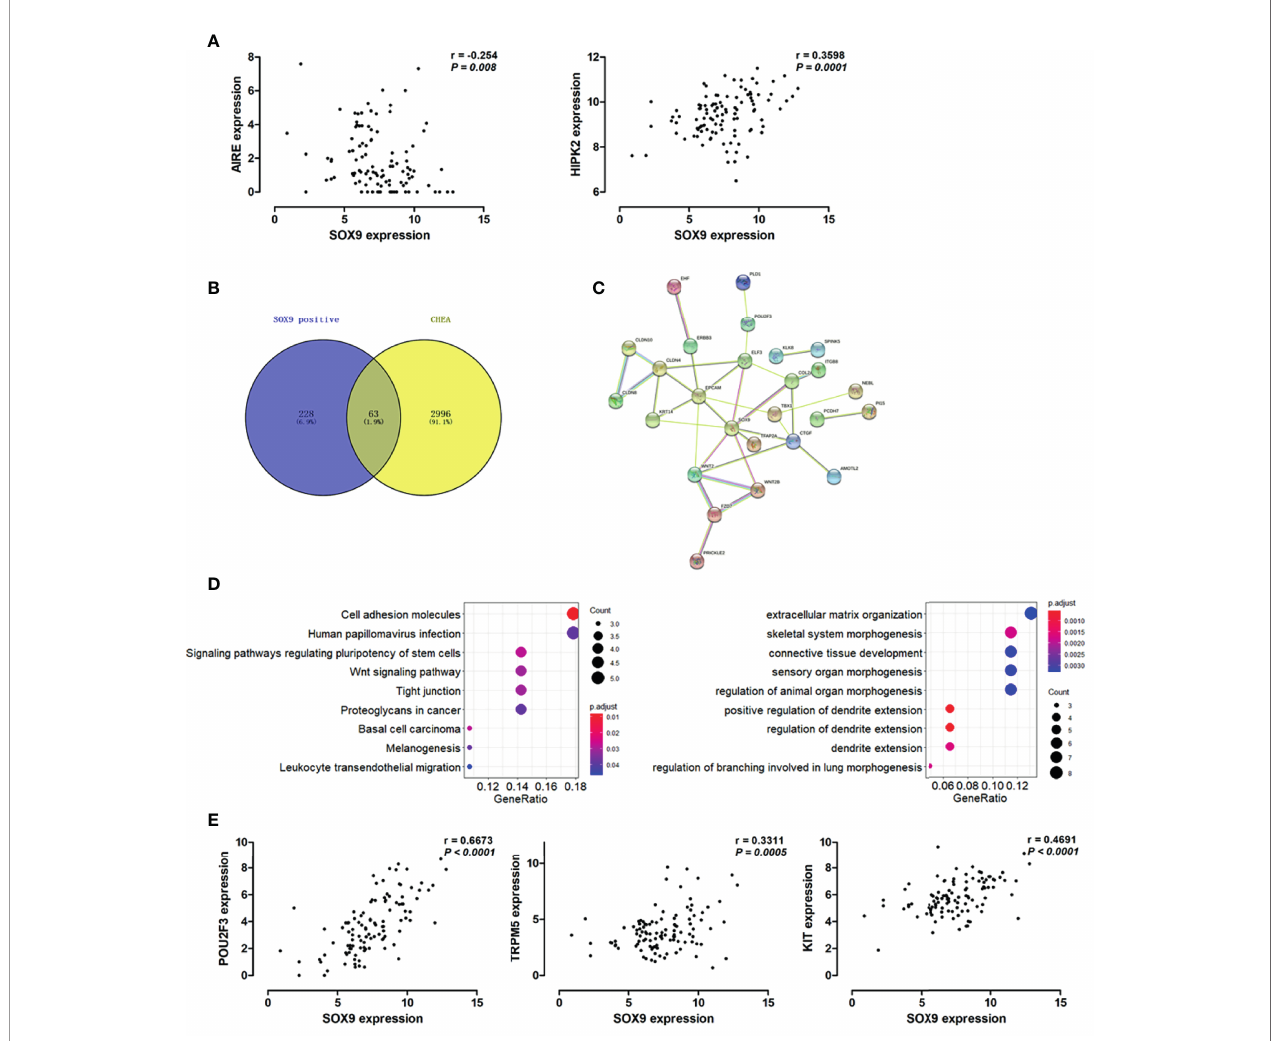
FIGURE 3 | SOX9 expression associated with the thymic tuft cells phenotype of thymomas. (A) Scatter plots illustrate the linear regression analyses for the associations between the expression of SOX9 and the expression of HIPK2 and AIRE in thymomas, respectively. (B) Venn diagram depicts the 63 common genes which are positively associated with SOX9 expression and regulated by SOX9. (C) Protein-protein interaction (PPI) network of these 63 common genes was constructed with the nodes with interaction con fi dence value > 0.95. Disconnected nodes were hidden in the network. (D) The dot-plot depicts the activity of the Kyoto Encyclopedia of Genes and Genomes (KEGG) pathways (right) and the biological processes terms (left) of these 63 genes. (E) Scatter plots illustrate the pearson correlation analysis for the associations between the expression of SOX9 and the expression of POU2F3, TRPM5, and KIT in thymomas,